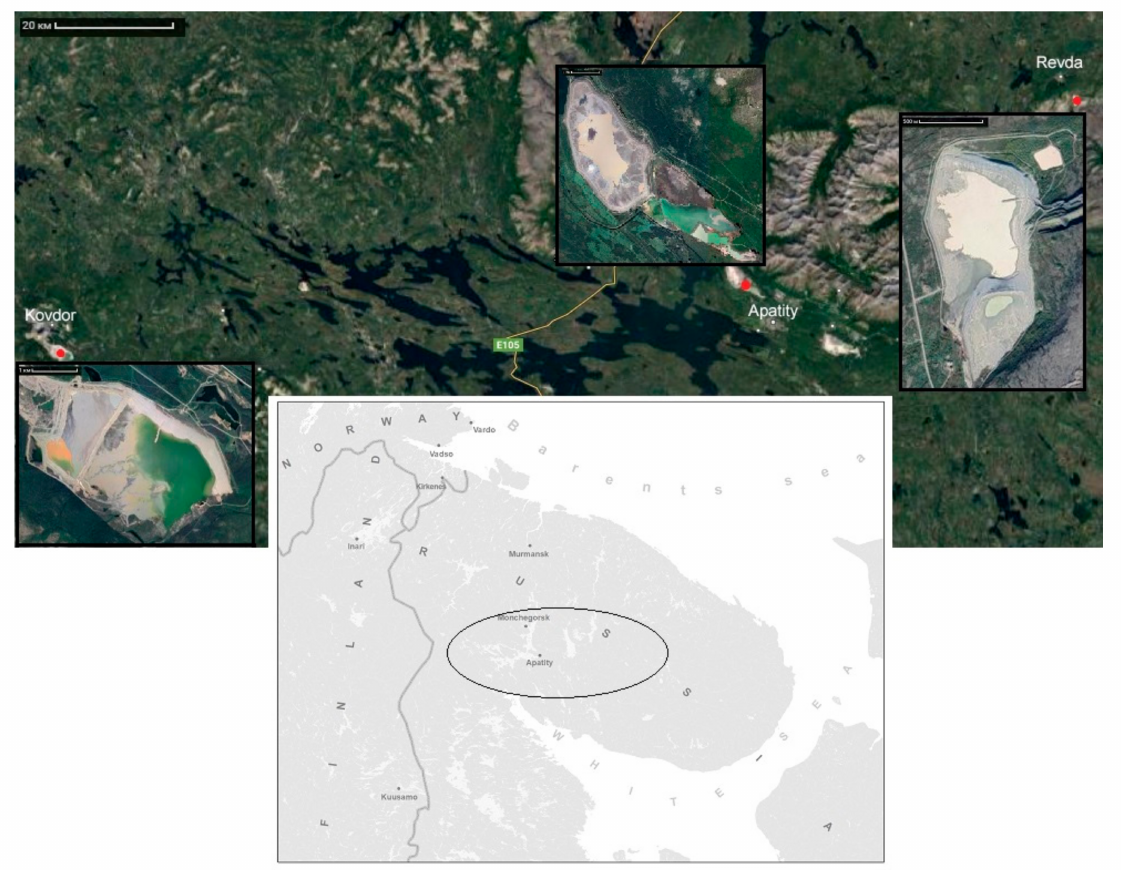
Figure 1. A schematic map of the study